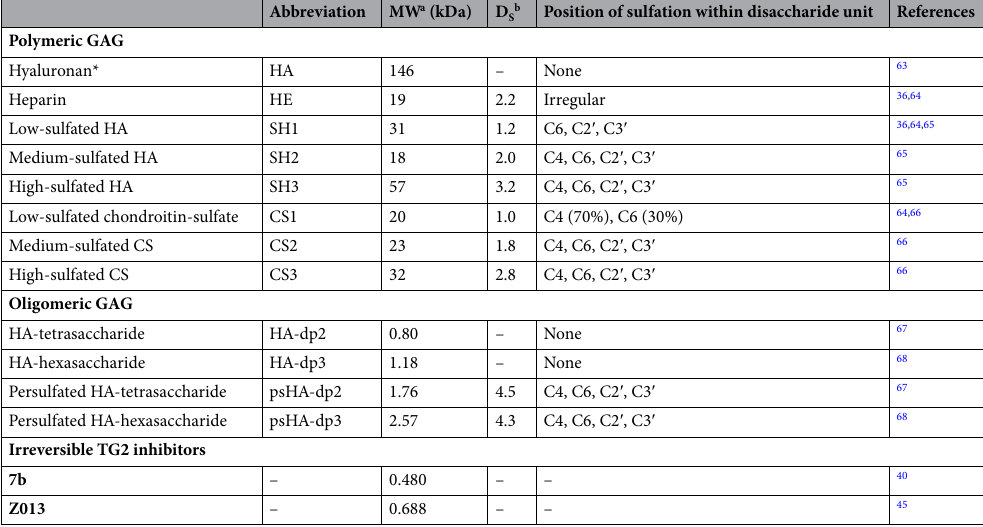
Table 3. Characteristics of the investigated polymeric and oligomeric GAG derivatives. a MW, molecular weight (weight-average molecular weight determined by gel permeation chromatography combined with a laser light scattering detector); b D S , degree of sulfation (average number of sulfate groups per disaccharide repeating unit); *HA with low MW obtained after thermal degradation; dp (degree of